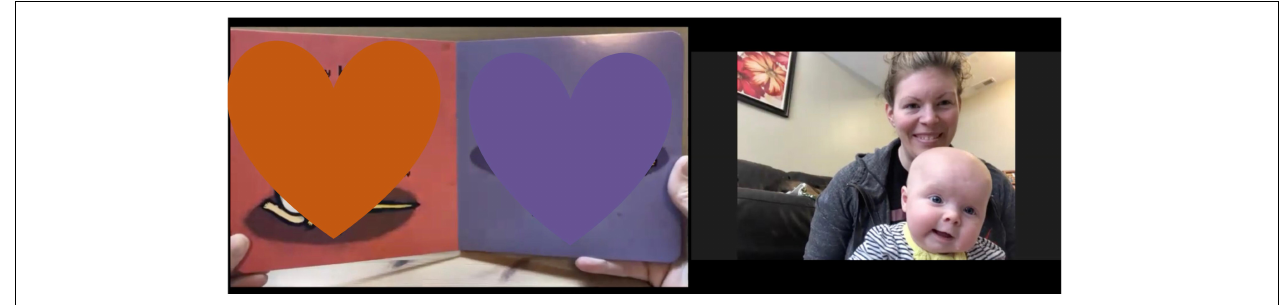
FIGURE 7 | Data from a book reading video.